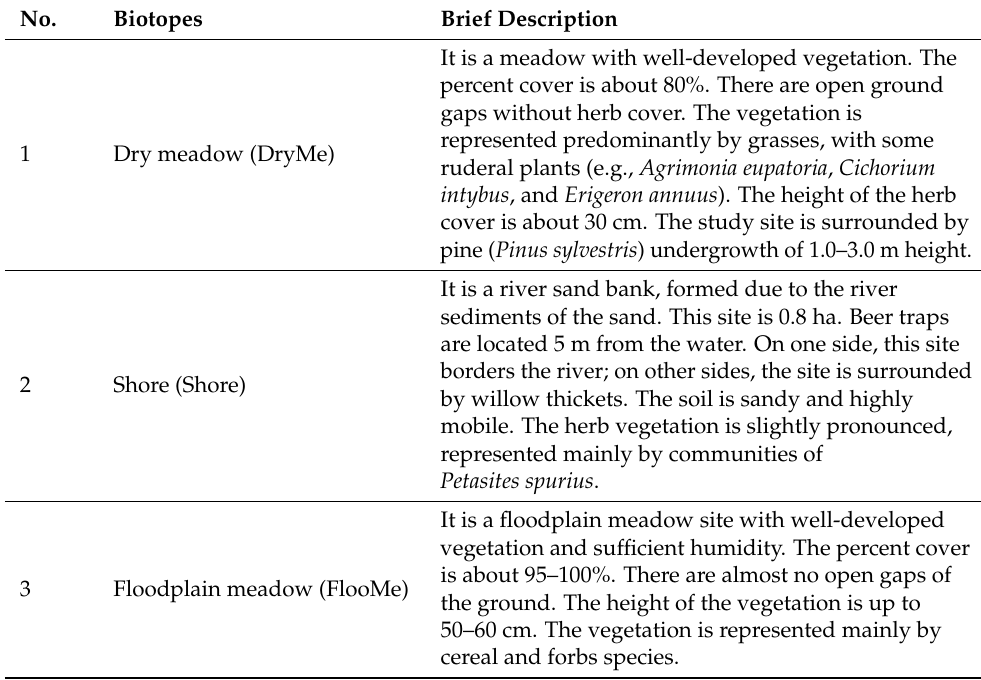
Table 1. Summary of the characteristics of the studied